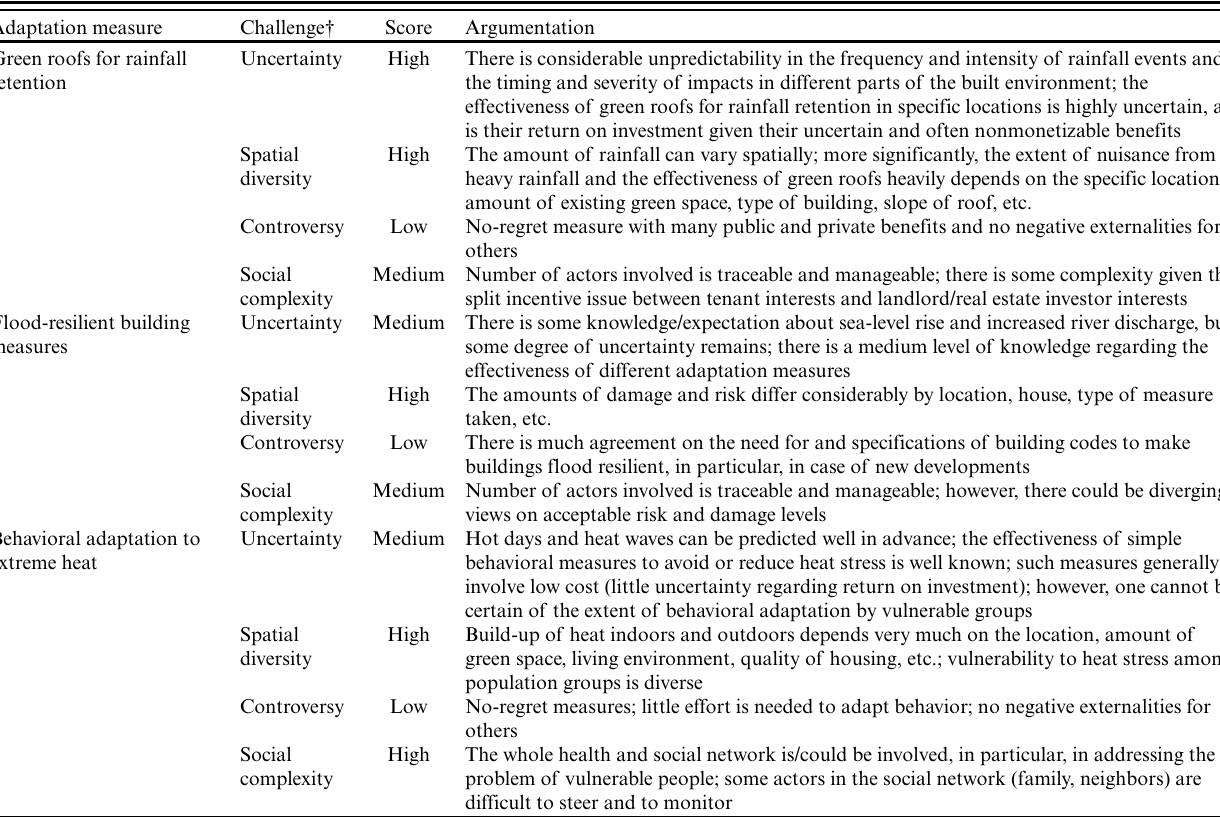
Table 4. Assessment of the four challenges for each of three adaptation